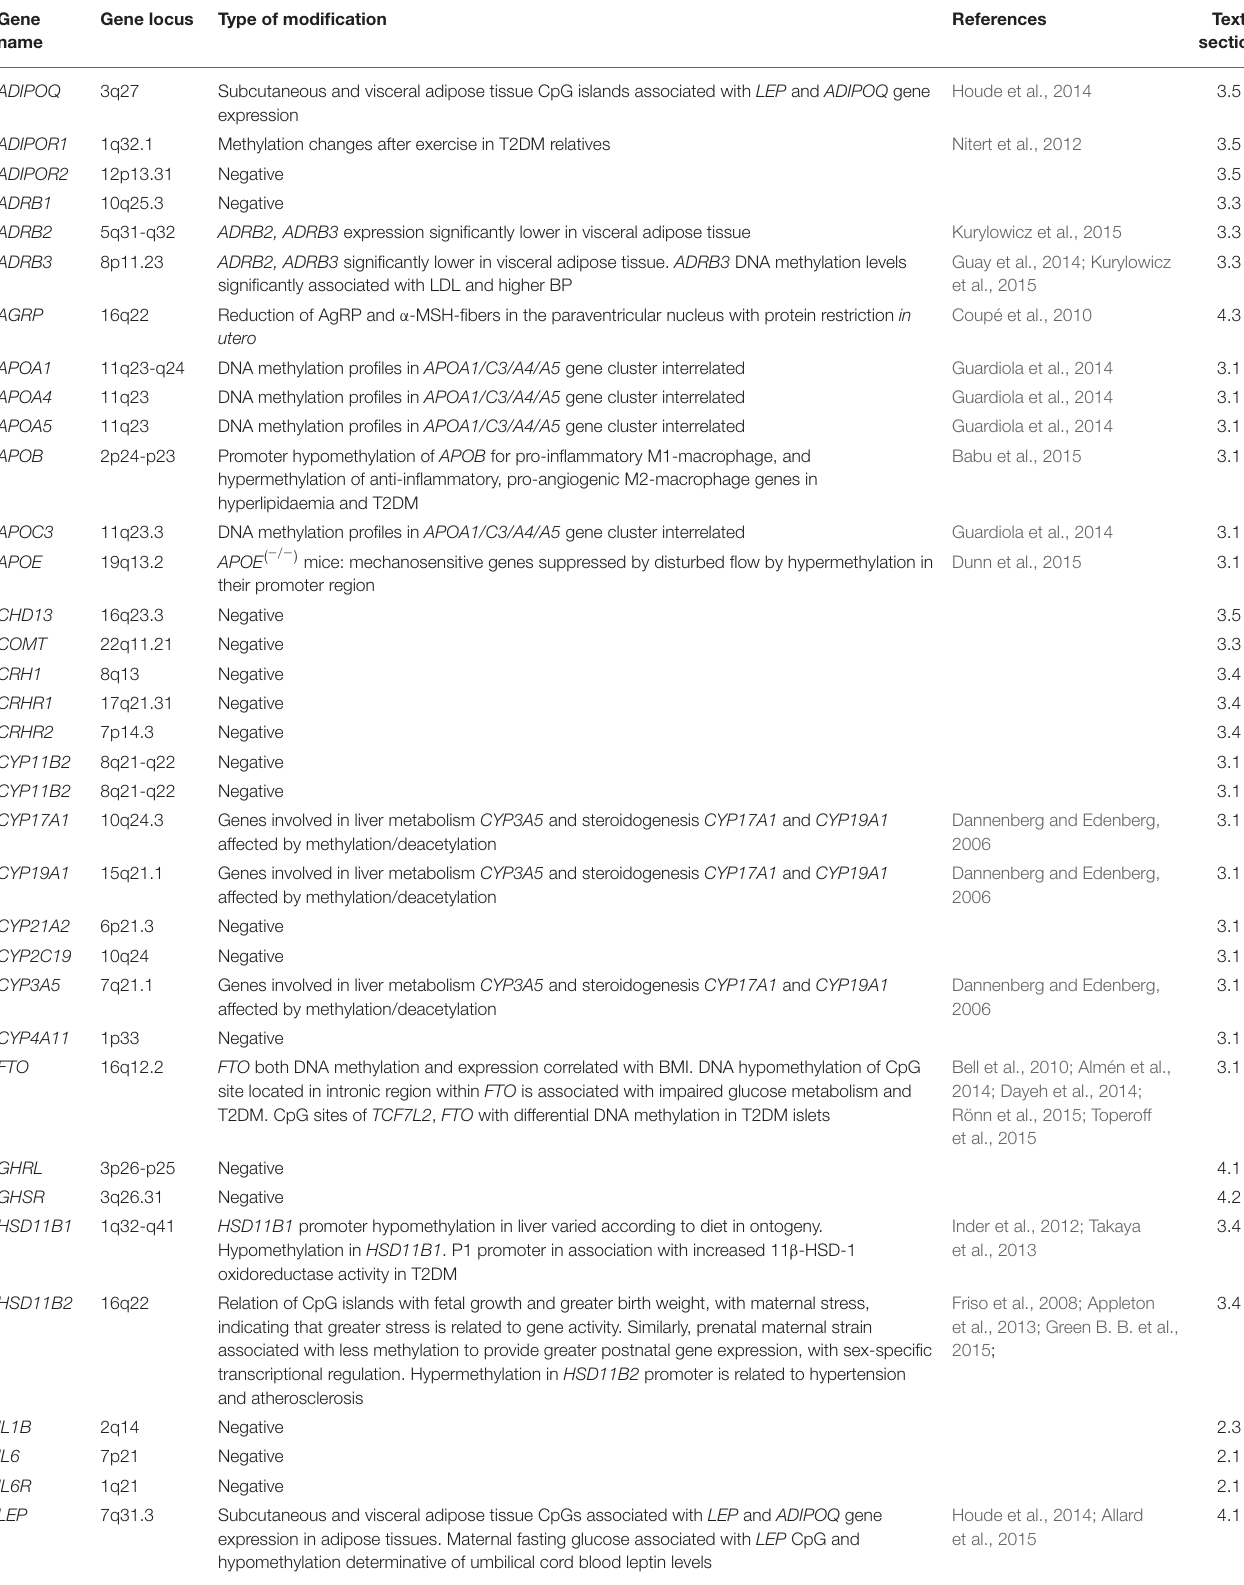
TABLE 1 | Risk genes and findings on epigenetic modification in the metabolic